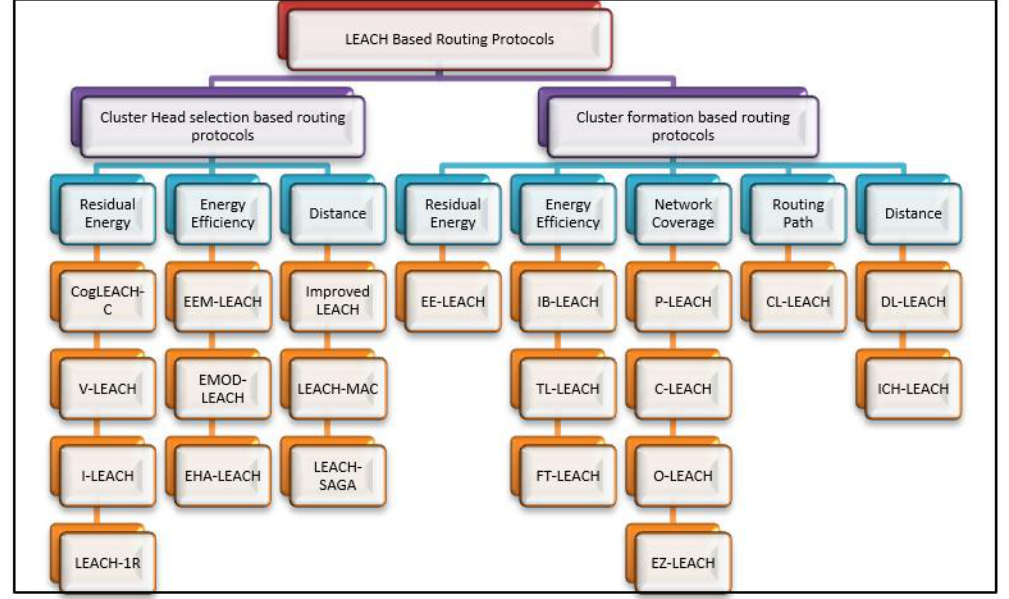
Figure 4. Proposed taxonomy of LEACH–based routing protocols in WSNs.